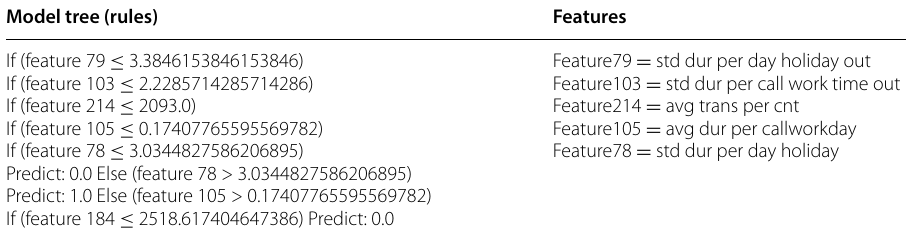
Table 17 Results for gender prediction Model tree (rules)